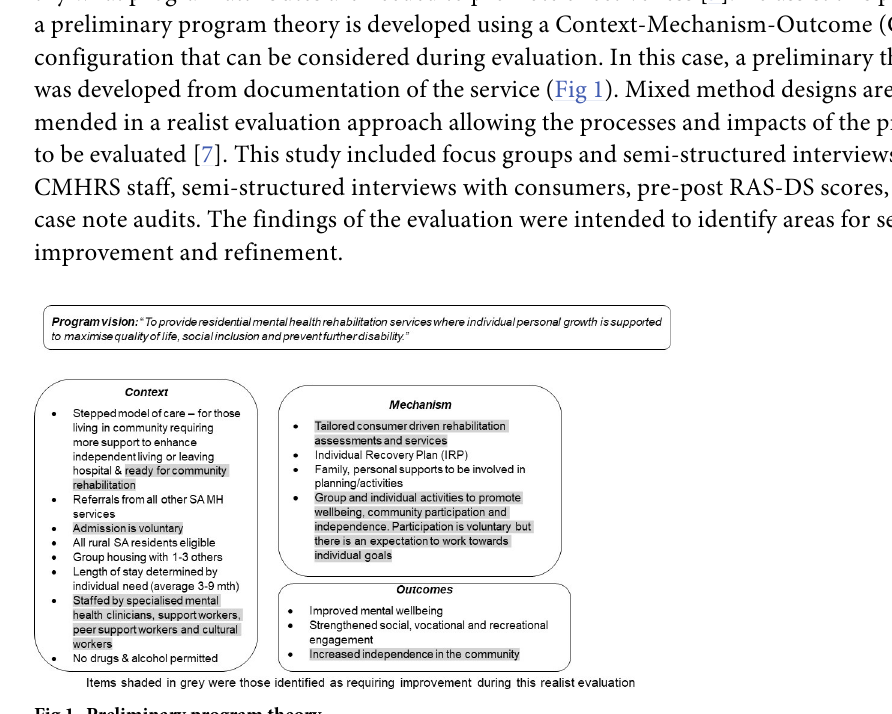
Fig 1. Preliminary program